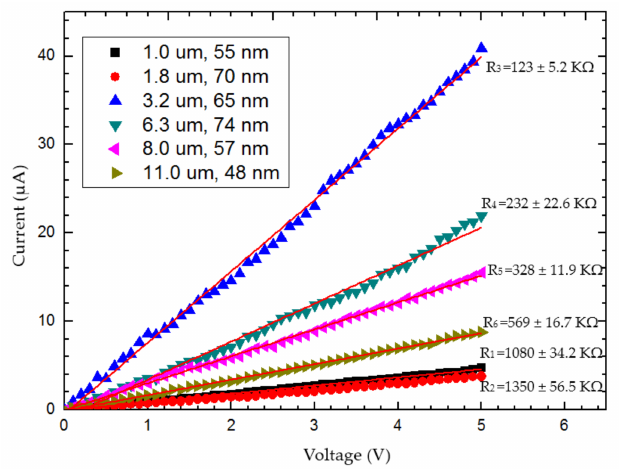
Figure 13. I-V characteristics of the measured